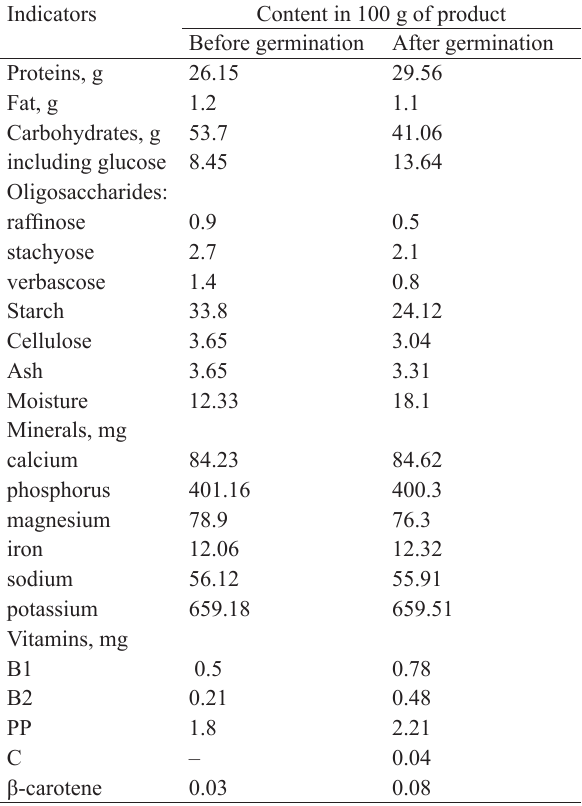
Table 2 Effect of germination on chemical composition of lentil seeds